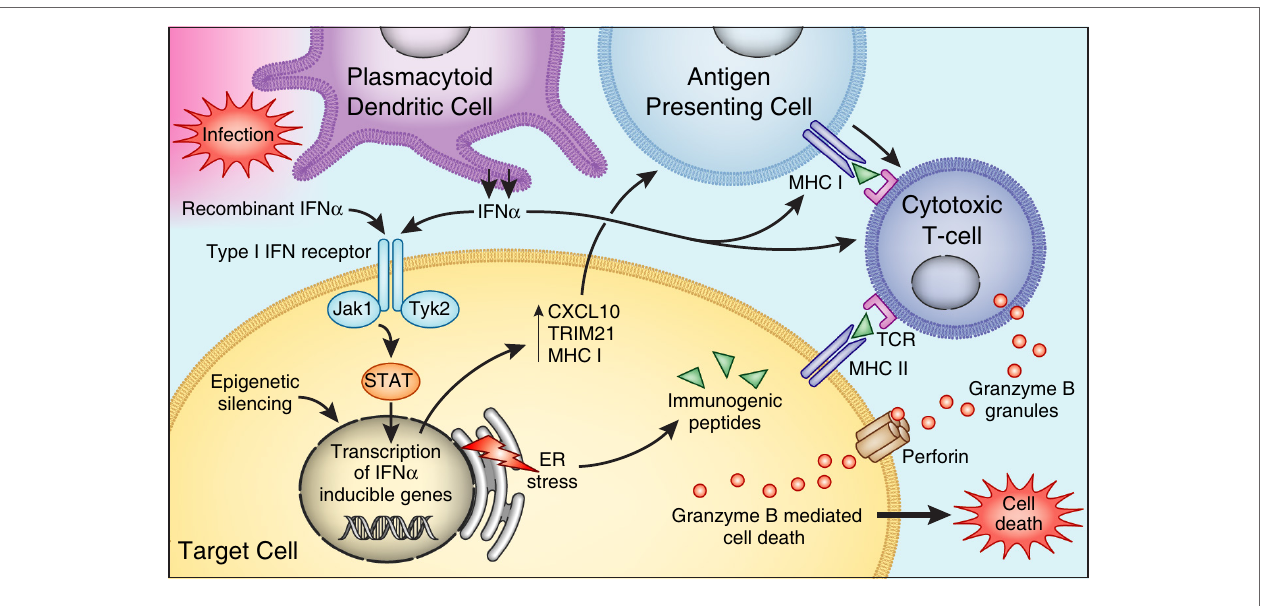
production of proinflammatory cytokines, (2) increase expression of HLA class I, (3) stimulation of cytotoxic T cells. IFN α also induces ER stress, and epigenetic modification of genes involved in the pathogenesis of type 1